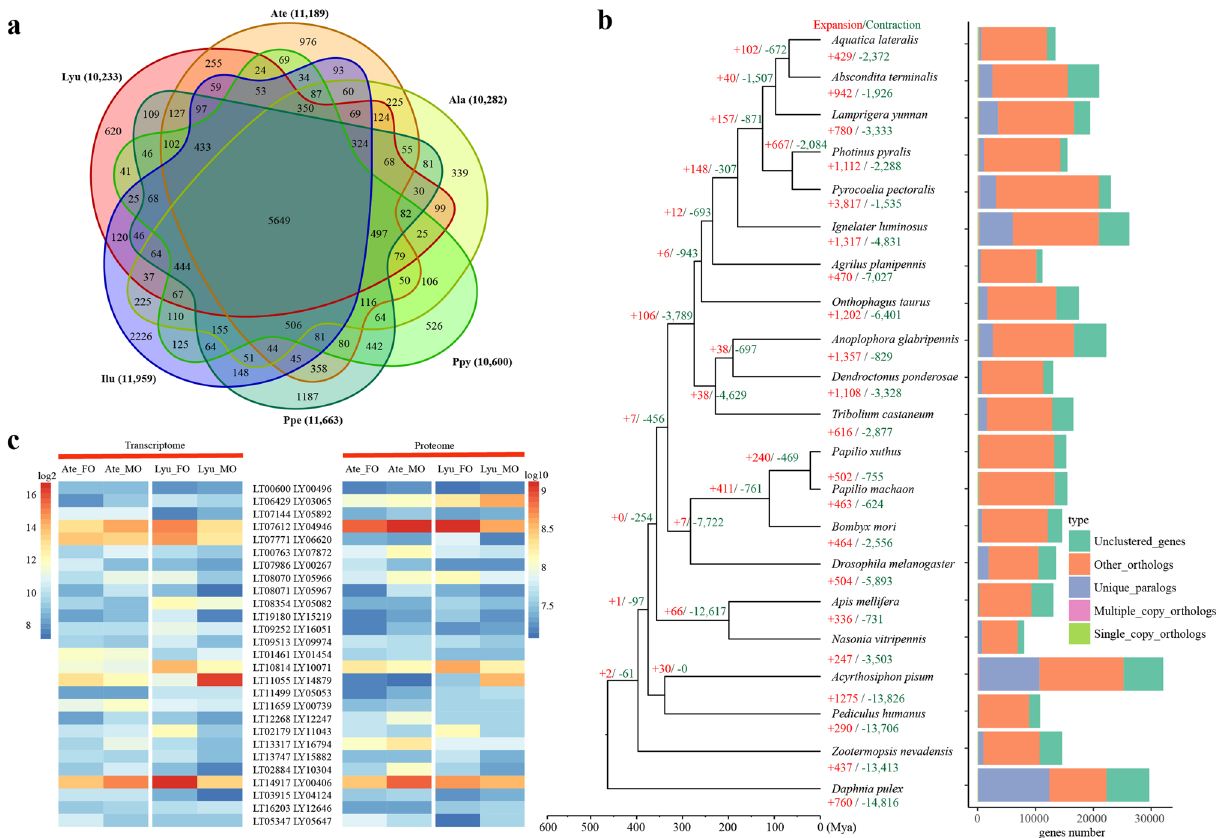
Figure 3. Evolution of gene families and highly expressed genes in luminous organs of two species. ( a ) Venn diagrams showing unique and overlapping protein families among six luminous insects including Lamprigera yunnana (Lyu), Abscondita terminalis (Ate), Aquatica lateralis (Ala), Photinus pyralis (Ppy), Pyrocoelia pectoralis (Ppe) and Ignelater luminosus (Ilu). The number in bracket shows the number of clustered gene families of each species. ( b ) The expanded and contracted gene families along the phylogenetic tree and ortholog assignment. Numbers on each terminus indicate the number of gene gains (+) or losses (−) for each taxon. Bars are subdivided to represent different types of ortholog clusters as indicated. “Single_copy_orthologs” indicates one to one gene among all genomes. “Multiple_copy_orthologs” indicates those orthologous genes present in multiple copies among all genomes. “Other_orthologs” indicates those genes present in at least two genomes, but not all genomes. “Unique_paralogs” indicates specific duplication in only one species. “Unclustered_genes” indicates no homologous relationship between one and any other taxa. ( c ) The expression of highly expressed orthologs in the luminous organs of L. yunnanna (Lyu) and A. terminalis (Ate) at both transcriptomic and proteomic levels. MO: luminous organ of male adult; FO: luminous organ of female